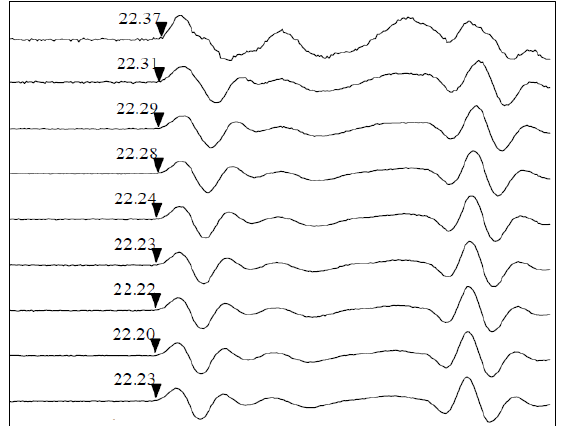
Figure 4. An example of waveforms for the P arrivals at different confining pressures from ultrasonic velocity test.